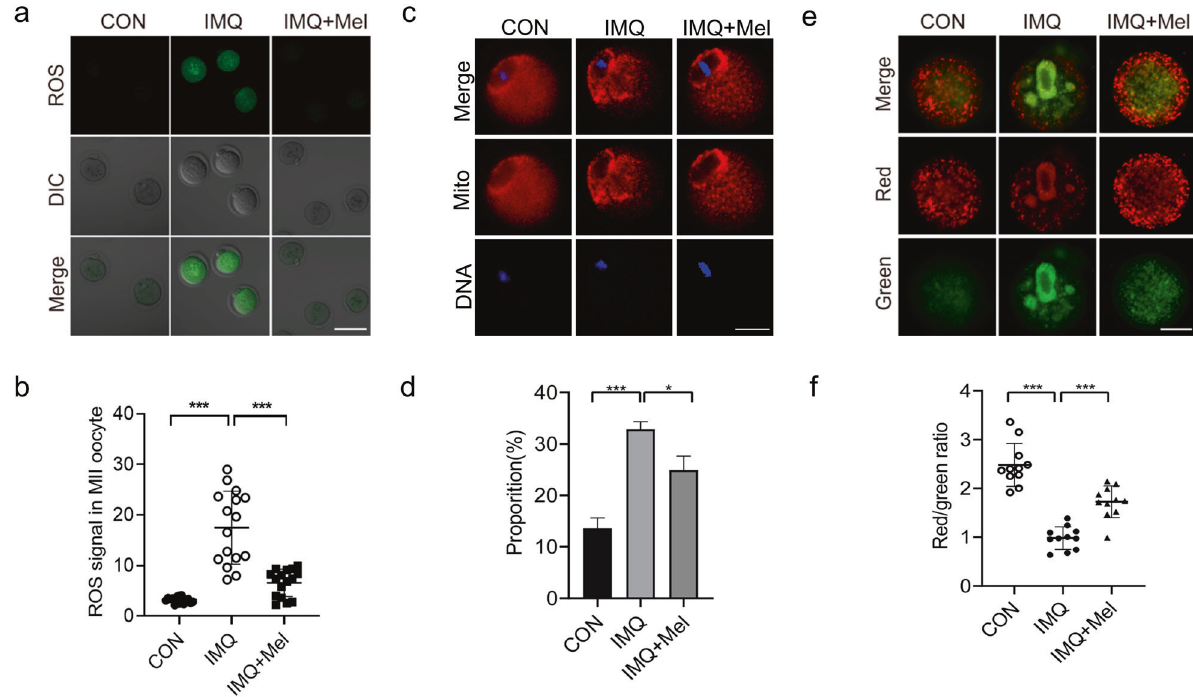
Fig. 6 Effects of melatonin supplement during in vitro maturation on ROS generation and mitochondrial function in oocytes from psoriasis-like mice. a Confocal images showing ROS signal (green) in CON, IMQ and IMQ + Mel oocytes. Scale bar: 150 µm. b Quantitative analysis of ROS signal ( n = 16 for each group). c The images showing red mitochondrial distribution in CON, IMQ and IMQ + Mel oocytes. Scale bar: 30 µm. d Quantitative analysis of mitochondrial distribution ( n = 15 for each group). e △ Ψ m was detected by JC-1 staining in CON, IMQ, and IMQ + Mel oocytes, red signal showed high △ Ψ m and green signal indicated low △ Ψ m. Scale bar: 30 µm. f Quantitation of JC-1 signal in CON, IMQ, and IMQ + Mel oocytes ( n = 14 for each group). The data are shown as mean ± SD. * P < 0.05, ** P < 0.01, *** P <